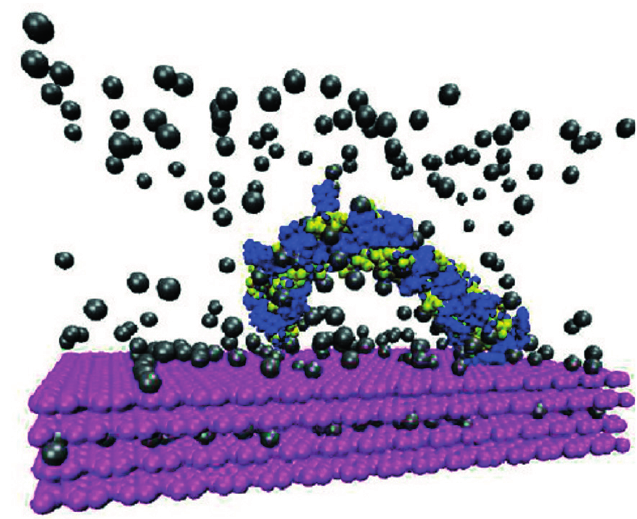
Figure 3. Simulation snapshot taken from simulations of a folded RNA (nitrogen and phosphorous atoms shown) strand tethered to a montmorillonite surface (silicon atoms shown). Atoms are colored as follows: Si (magenta), Ca (gray), N (blue), P (yellow). Water molecules are hidden to aid in viewing. Reprinted with permission from [63]. Copyright 2010 American Chemical